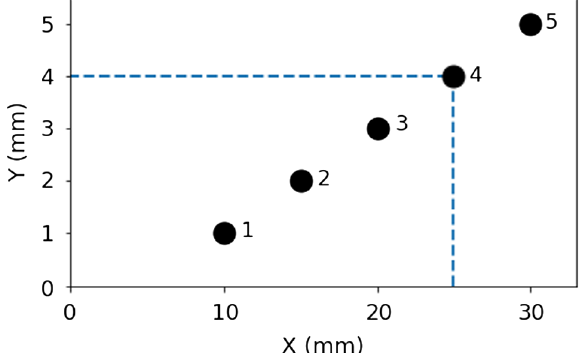
FIG. 4. Comparison of the evolution of average fitness with and without machine learning for 135 generations. Without machine learning, the evolution process can sometimes stop, or even regress. On the other hand, the fitness convergence becomes faster and steadier with the introduction of machine sorted. The top three elite clusters are selected, based on their average fitness, to define an “ elite ” search range.